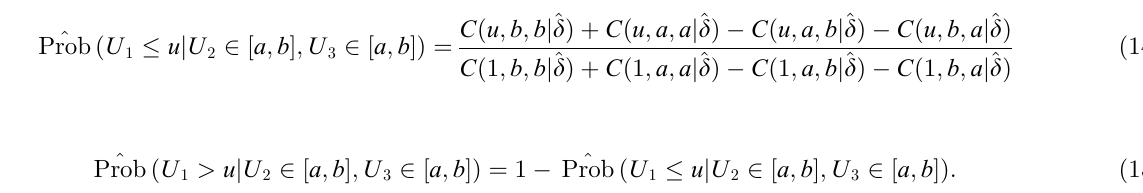
^ d B is the Bayesian estimator obtained by Importance Sampling (Eq. (13) with m = 100)